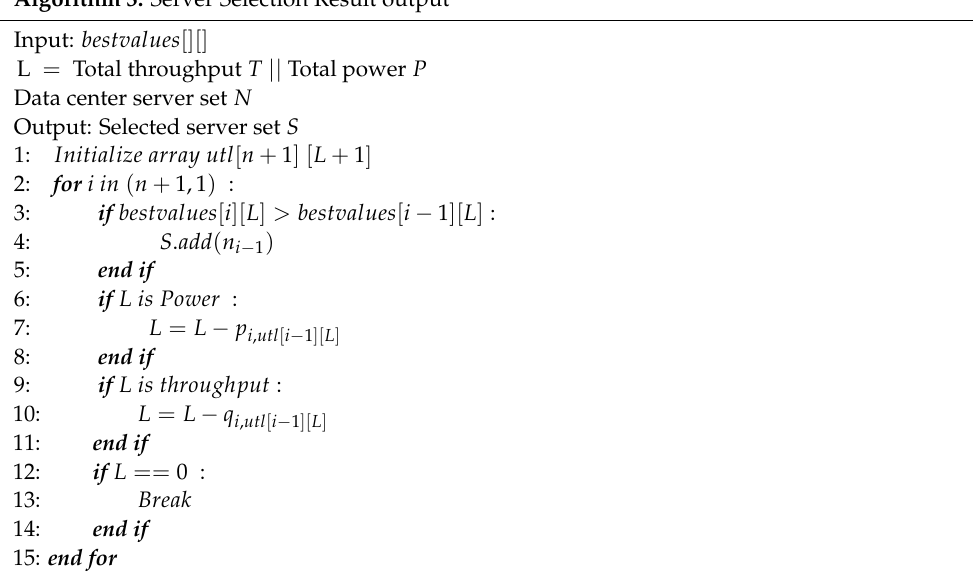
Algorithm 3: Server Selection Result